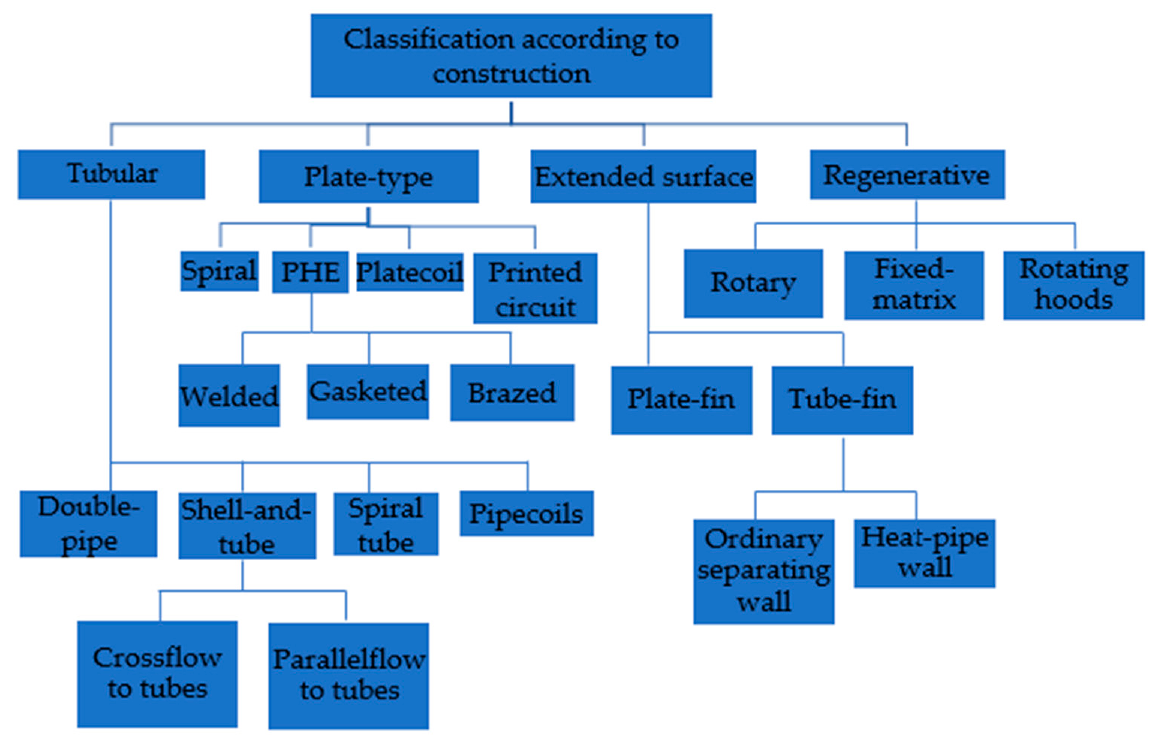
Figure 1. Classification of HXs based on construction.